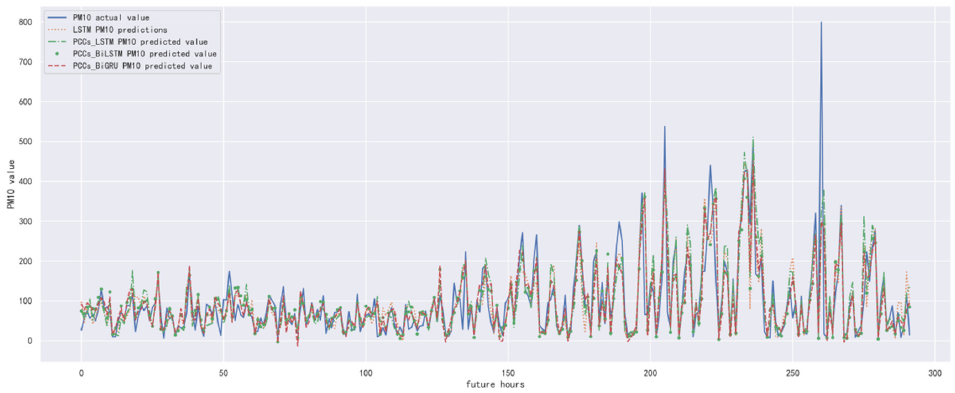
Figure 19. The schematic diagram of predicted PM 10 concentration in the next four hours.